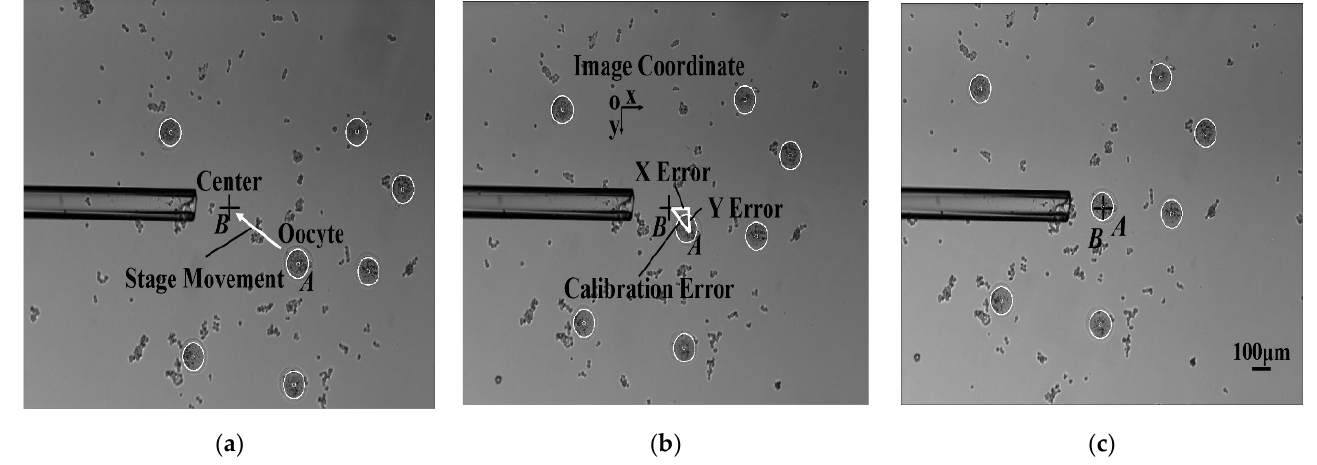
Figure 8. Comparison of two calibration methods. Oocyte A was moved to the center B by stage movement. After stage movement, the calibration error between the oocyte A position and the center B position was calculated. The calibration error was divided into the X error and the Y error along the x and y direction of the image coordinates, respectively. ( a ) Before stage movement; ( b ) After stage movement by manual calibration; ( c ) After stage movement by automated calibration.